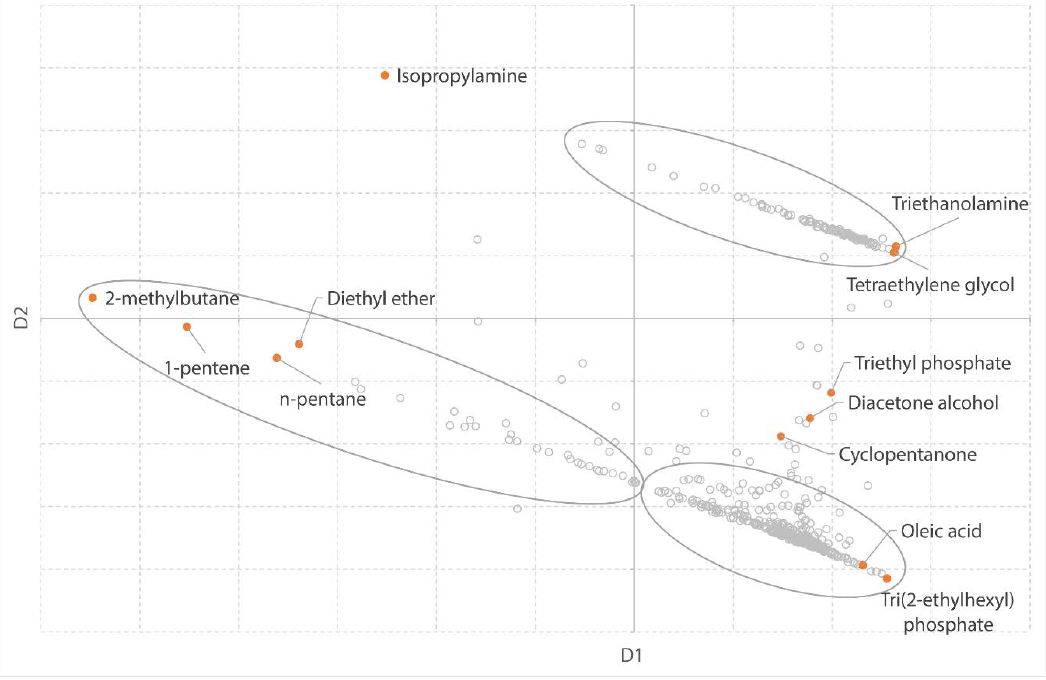
Figure 1. Multidimensional scaling (MDS) plot of all 500 solvents based on their 22 physical properties. Dimension 1 (D1) on x-axis and dimension 2 (D2) on y-axis. Three main groups of solvents are highlighted.